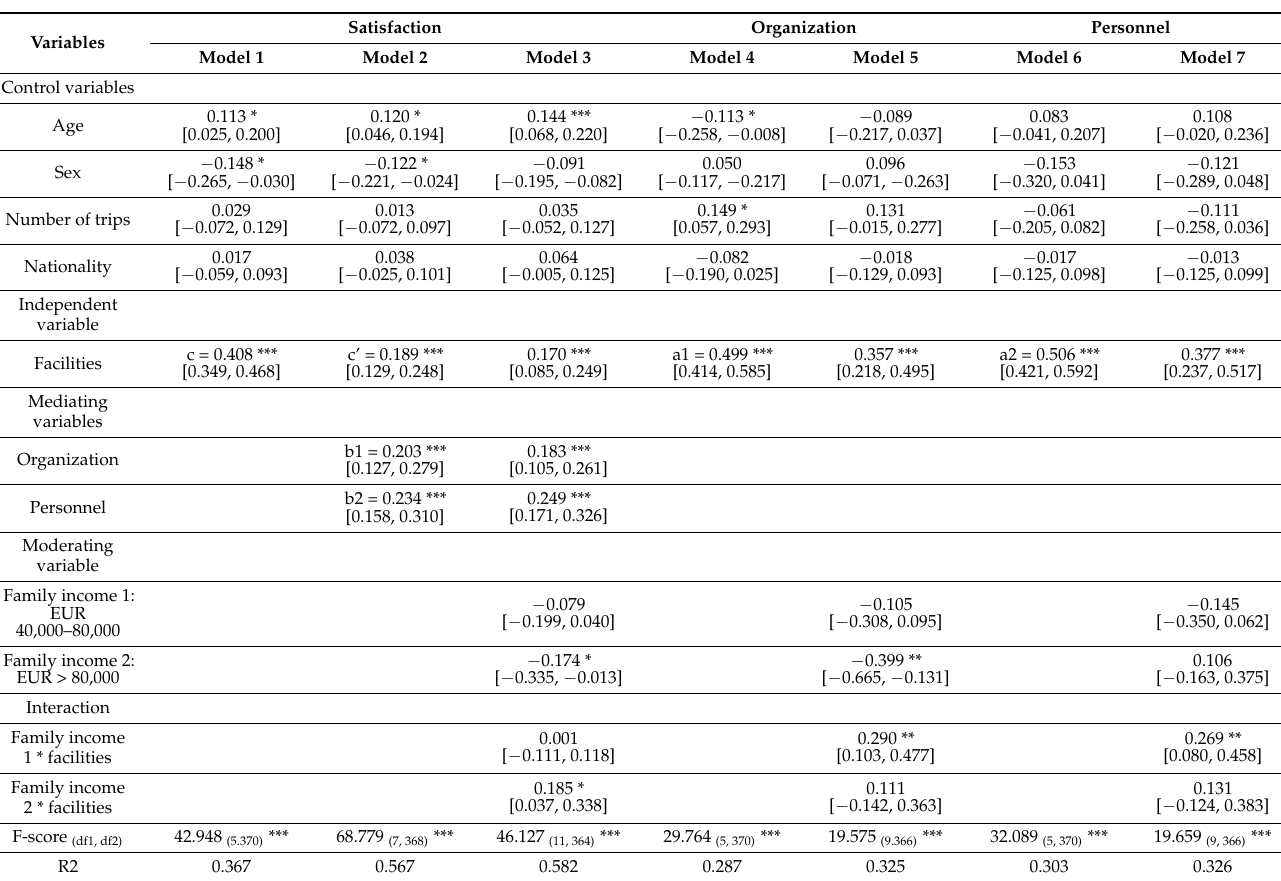
Table 6. Results of the regression analysis.